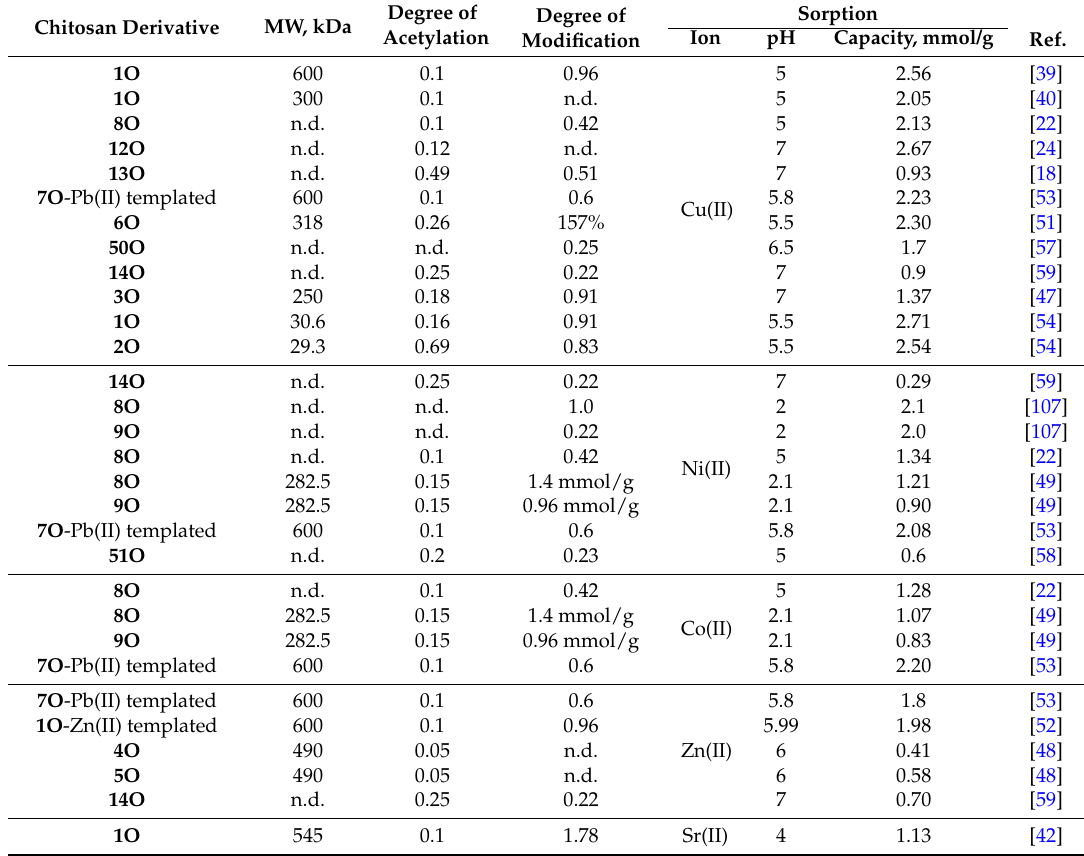
Table 2. Structure and sorption properties of O-containing chitosan derivatives. Chitosan